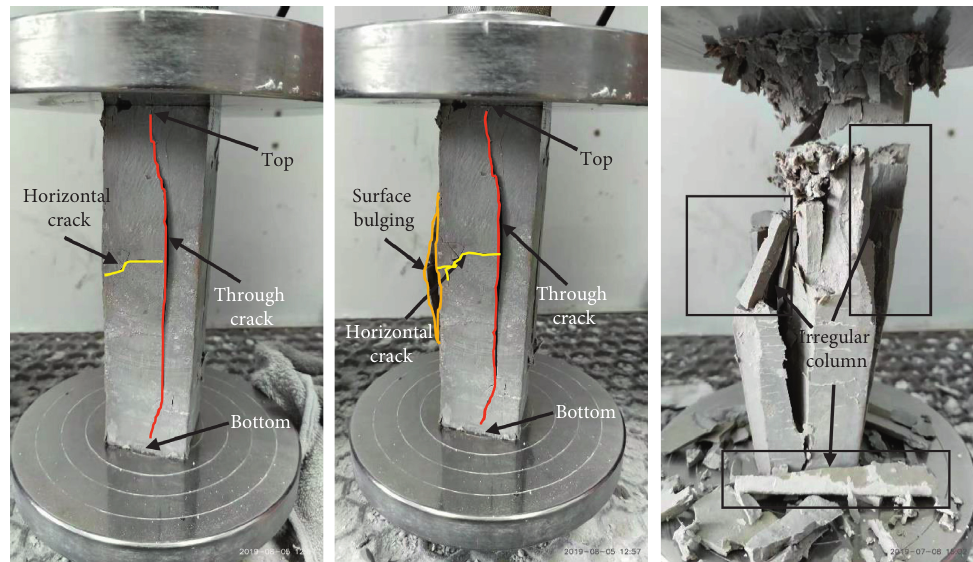
Figure 7: Fracture morphology of the cuboid specimen under compression.